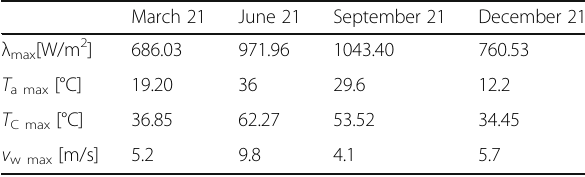
Table 2 Maximum values of atmospheric condition for the used